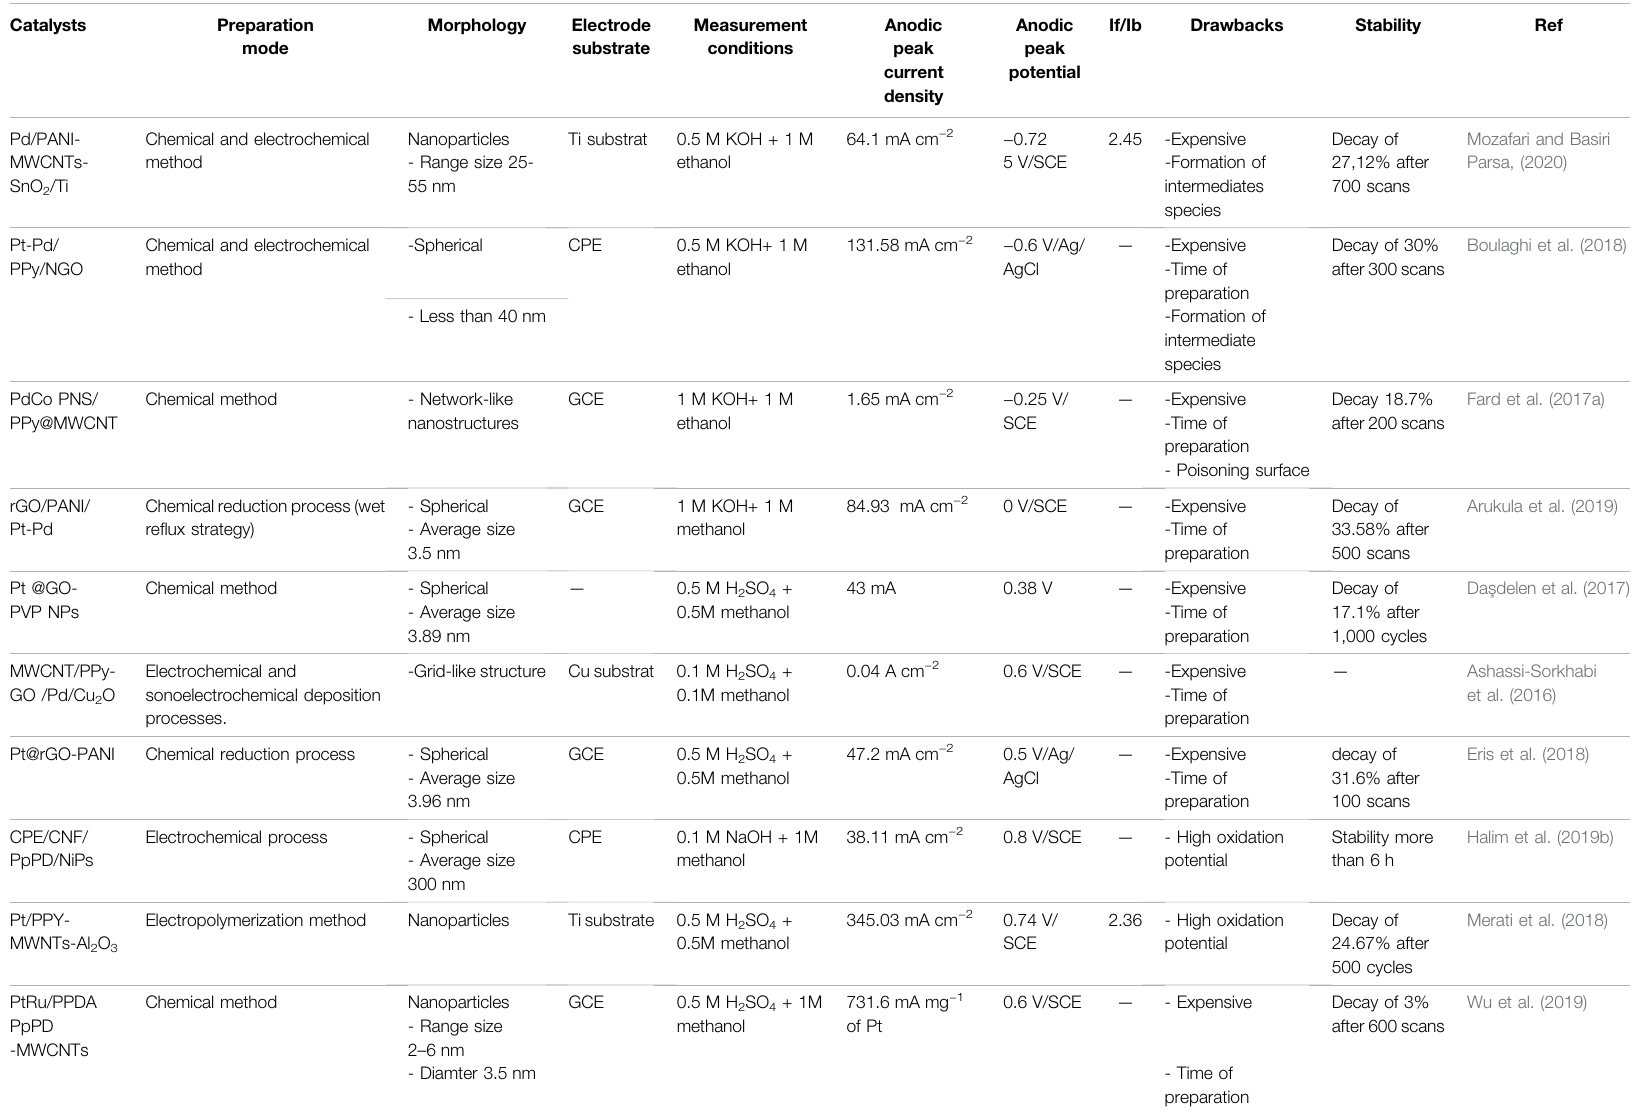
TABLE 4 | Electrochemical properties and electrocatalytic performances of metallic-based conducting polymers and carbon materials catalyst applied for alcohol